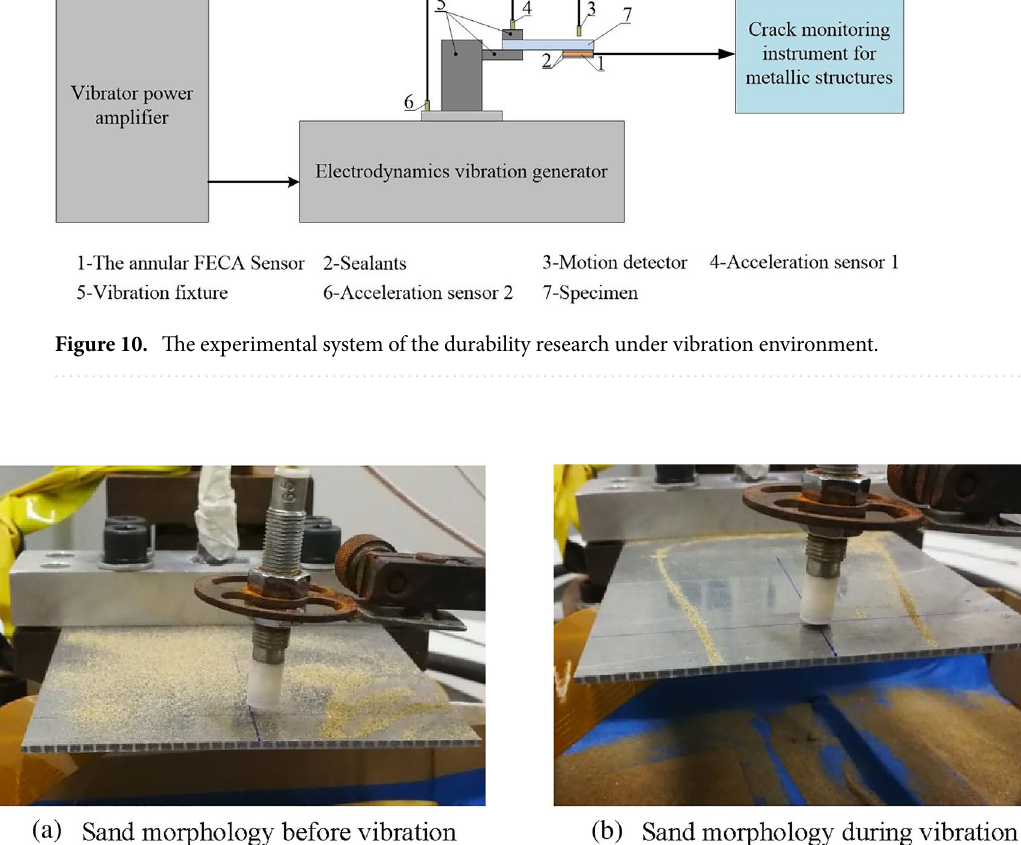
Figure 11. Determination of vibration mode by